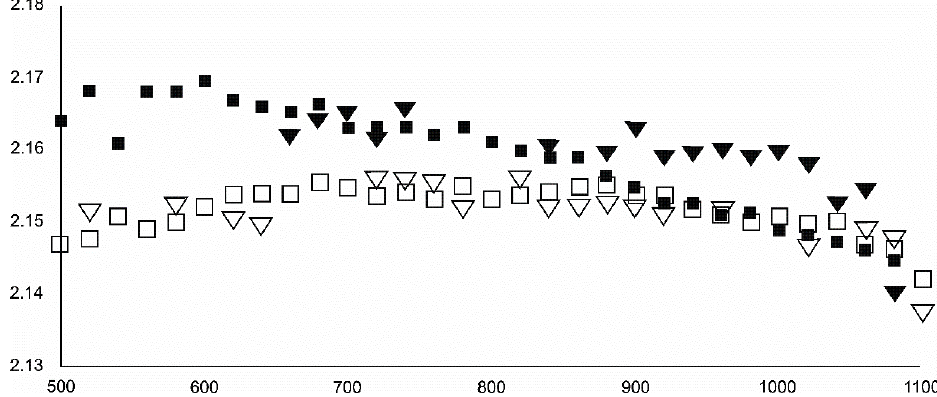
Figure 13. Relation of temperature (bottom axis, in °C) to positions of major reflections (in Å) for wüstite. LSCB sample—filled symbols. USCB sample—empty symbols. Squares—main reflection. Triangles—main reflection second-wüstite-phase.